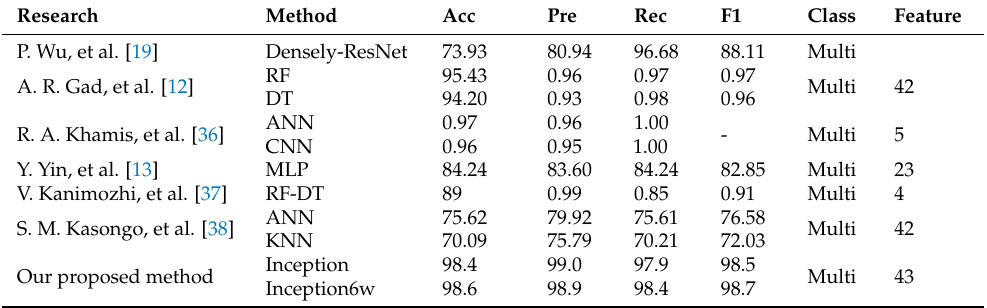
Table 11. Comparison of the results with previous studies using the UNSW-NB15